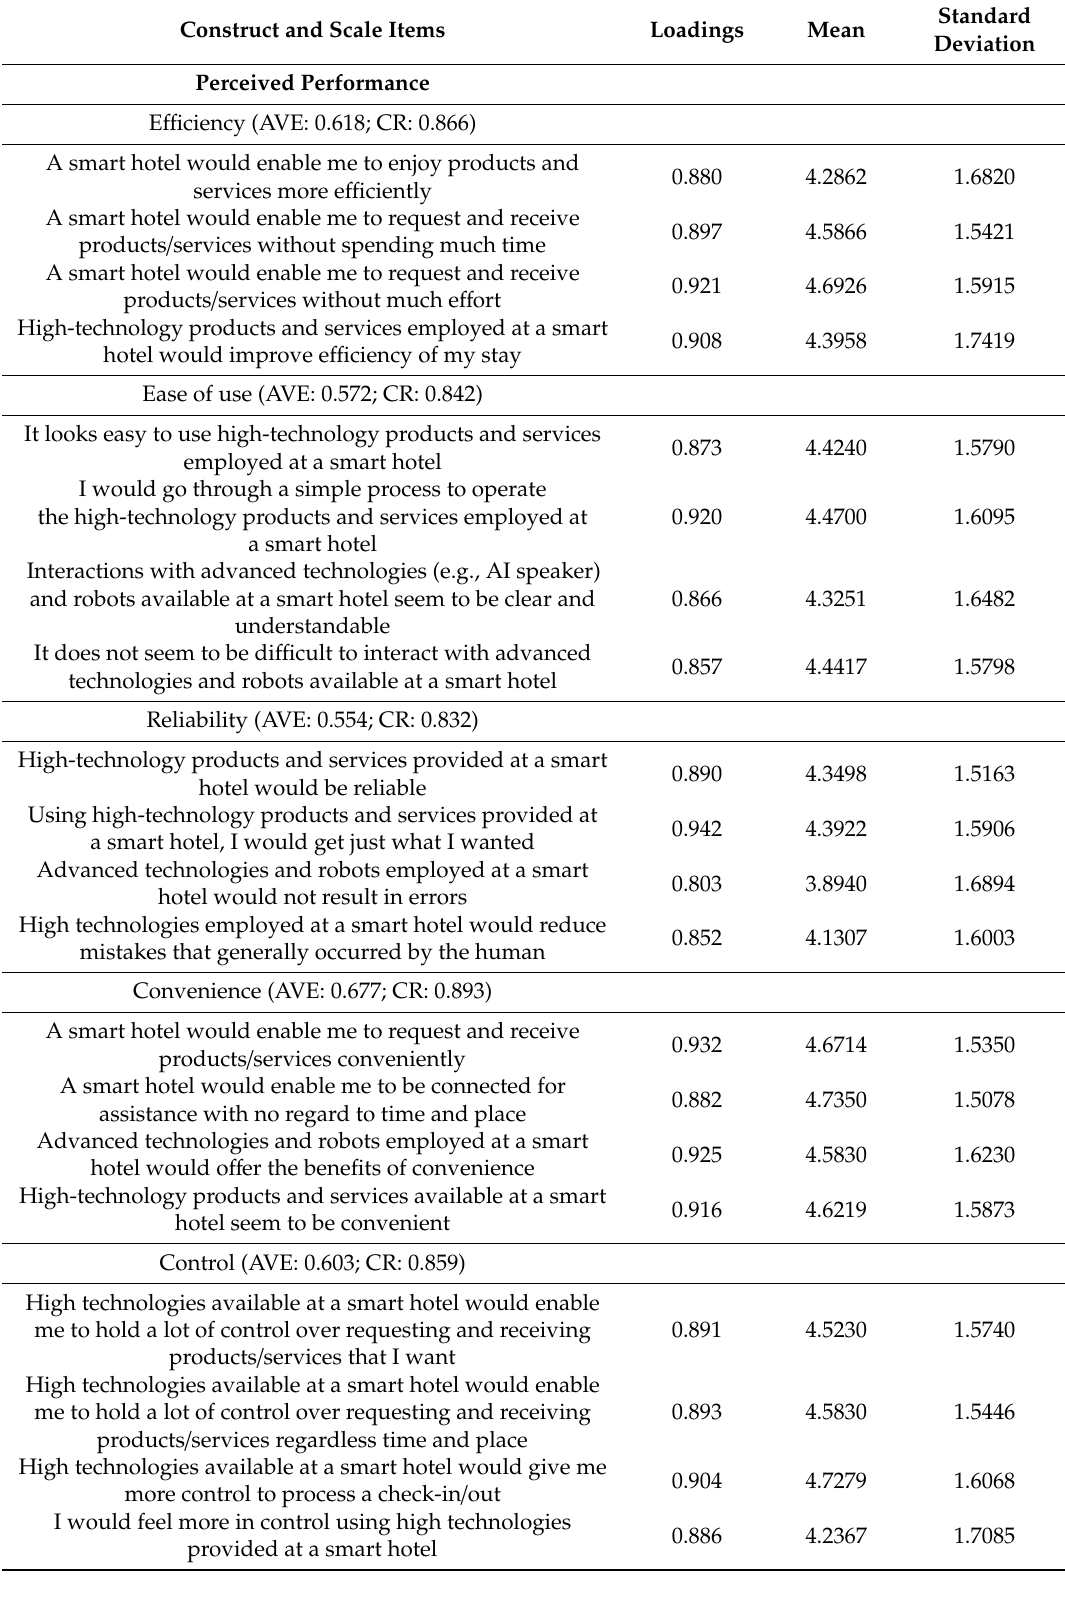
Table 1. Summary of the confirmatory factor analysis